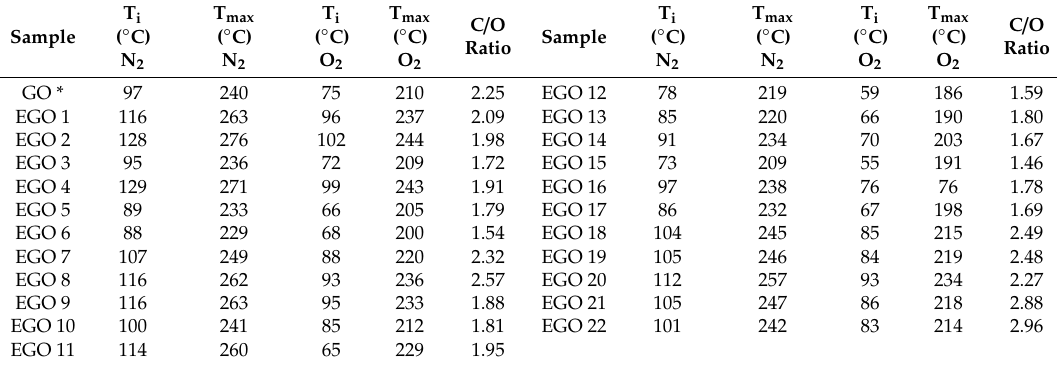
Figure 7. TGA thermograms under nitrogen ( a ) and air ( b ) for EGO 8. Table 2. Characteristic degradation temperatures of the EGOs obtained from TGA experiments under nitrogen and dry air atmospheres.